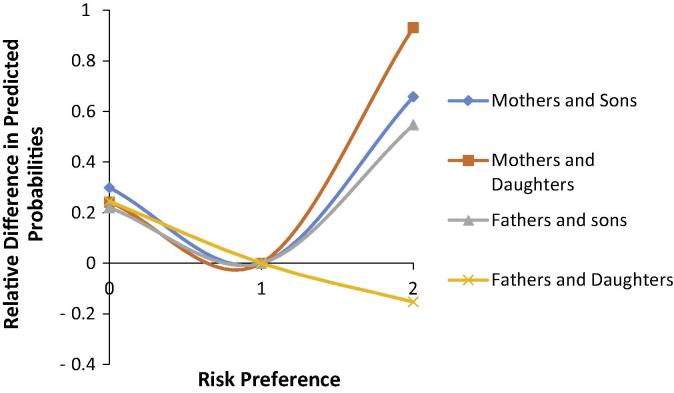
Relative difference in predicted probabilities of parents and offspring having same and conflicting risk preference categories. Notes: on the x-axis 0 = risk neutral, 1 = risk neutral, 2 = risk seeking. The conflicting risk preference categories are offspring risk averse and parent risk seeking, offspring risk neutral and parent risk neutral amd offspring risk seeking and parent risk averse.